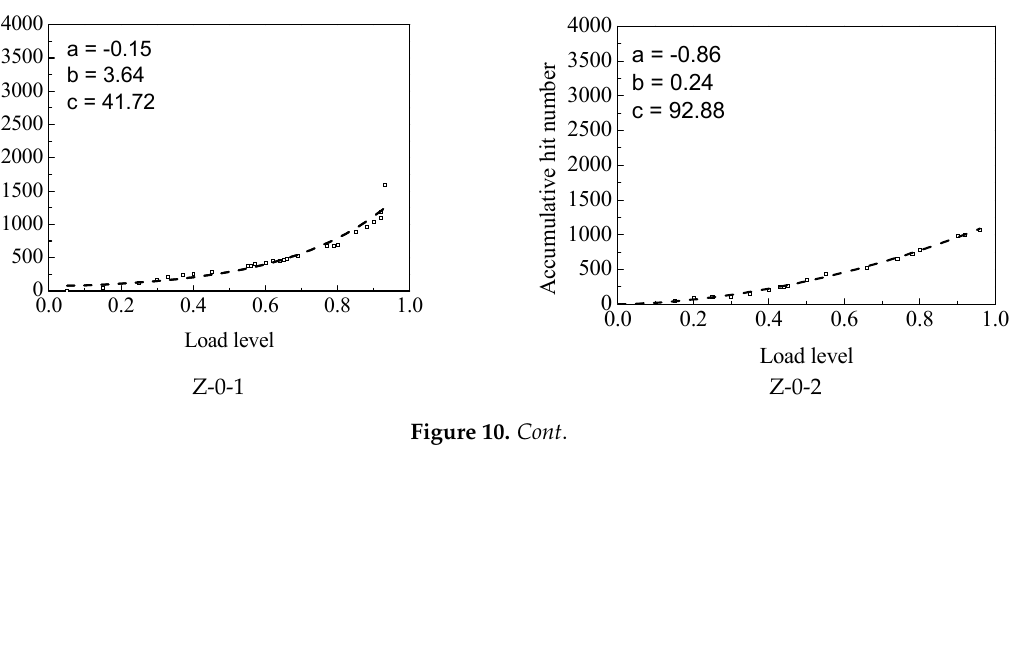
Figure 9. Correlation curve of the load and damage degree.